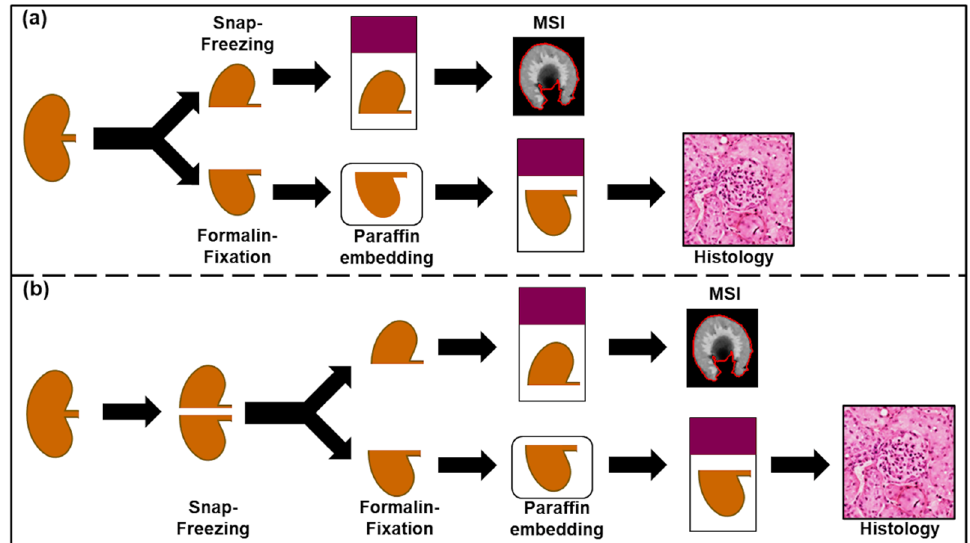
Figure 6. ( a ) Current sample collection workflow including separation of samples during collection. ( b ) facilitated workflow with snap freezing of all specimens during sample collection and subsequent fixation of specimens for histological evaluation.